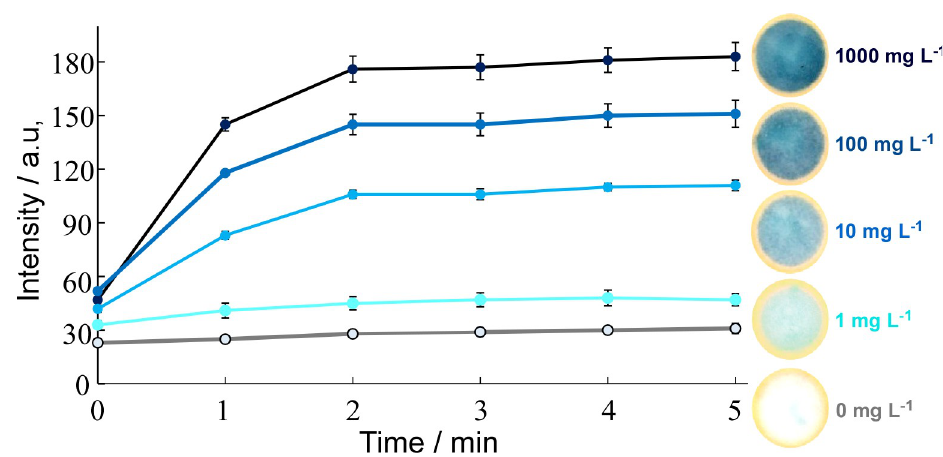
Fig 4. Formation of the blue PMB complex over time at different phosphate concentrations. The colour intensity was found to increase for up to 2 min and then plateau (n = 3).